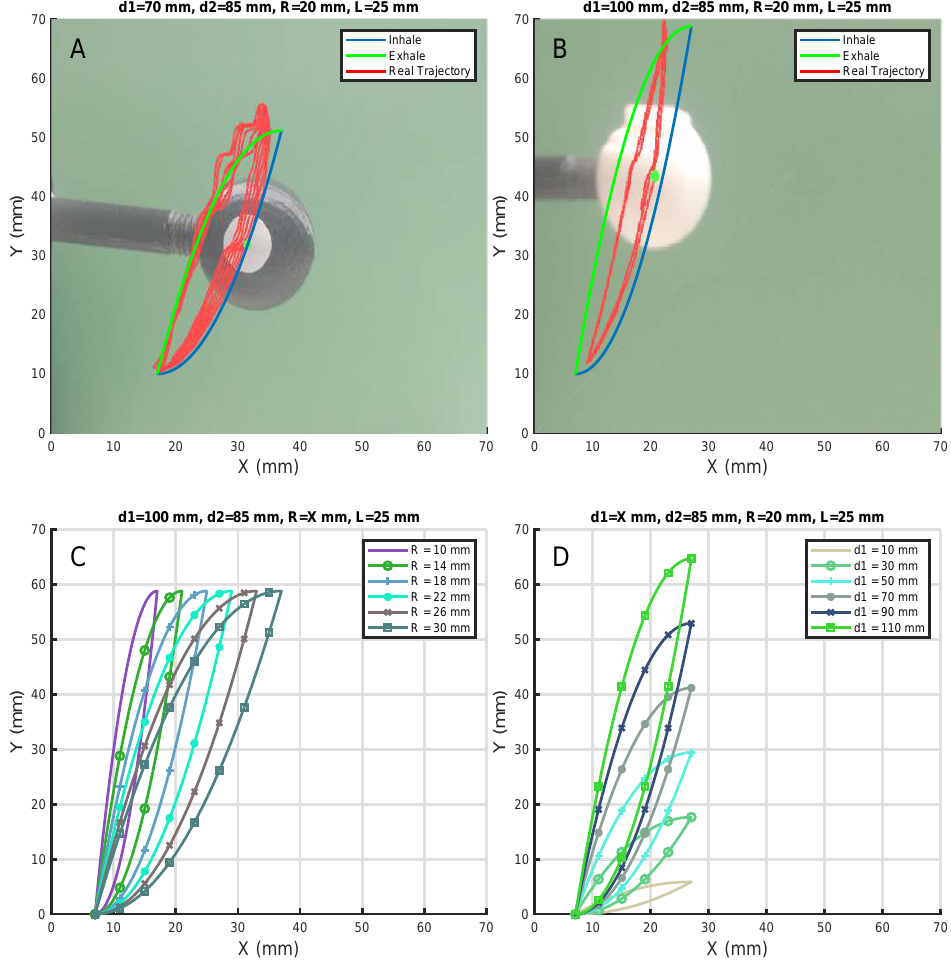
Figure 6. ( A ) Setup for a wider tumor trajectory is shown. ( B ) Setup for higher tumor trajectory is shown. ( C ) All possible trajectories by modifying the r parameter are displayed. ( D ) Possible trajectories by modifying d1 parameter are